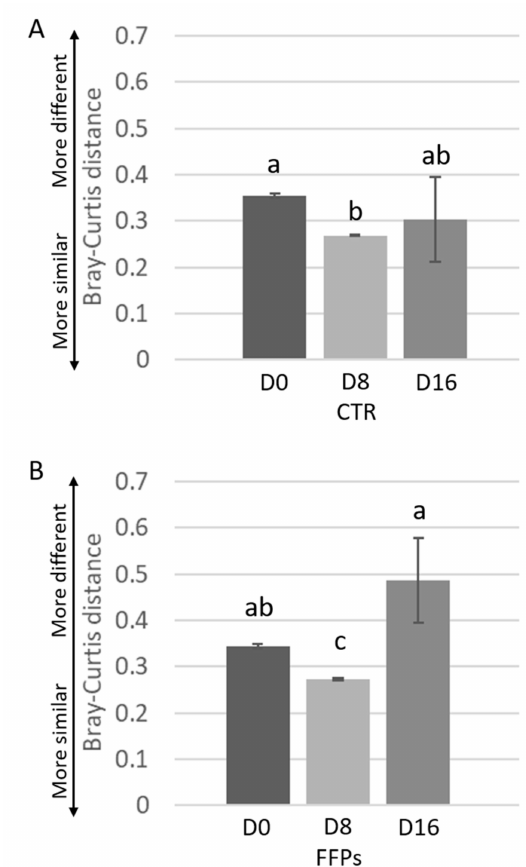
Figure 4. Inter-individual variations of the gut microbiota of the piglets during time. Inter-individual variations were determined by average Bray-Curtis distances between individuals at the beginning of the trial (D 0), after eight days (D 8), and after 16 days (D 16) the use of the experimental diets. Results are shown for pigs fed CTR (A) and FFPs (B) diets. Mean values ± SEM are shown. Di ff erent letters above the bar denote significant di ff erence tested by Student’s t -test with 1000 Monte Carlo permutations. Regarding the gut microbiota composition in D 16, the LefSe analysis showed that the enriched phylotypes from the CTR group predominantly belonged to the class Bacilli and genus Lactobacillus, whereas phylotypes from the FFP group belonged to the phylum Proteobacteria (Figure